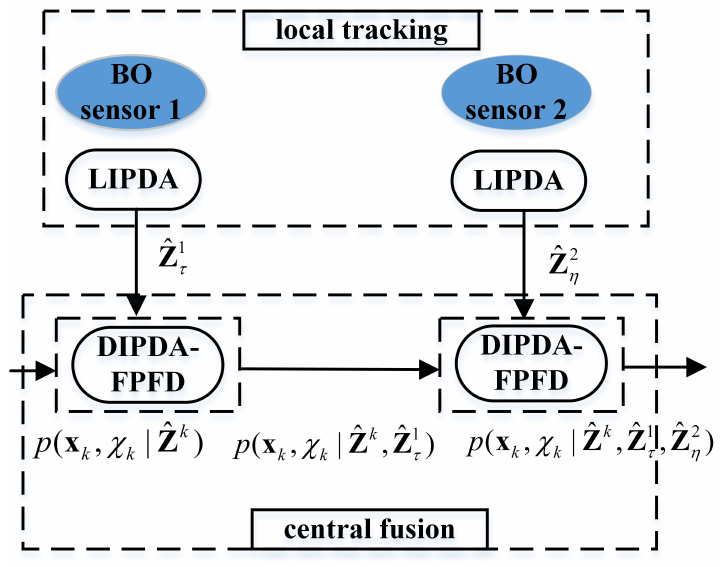
Figure 1. Framework of the proposed